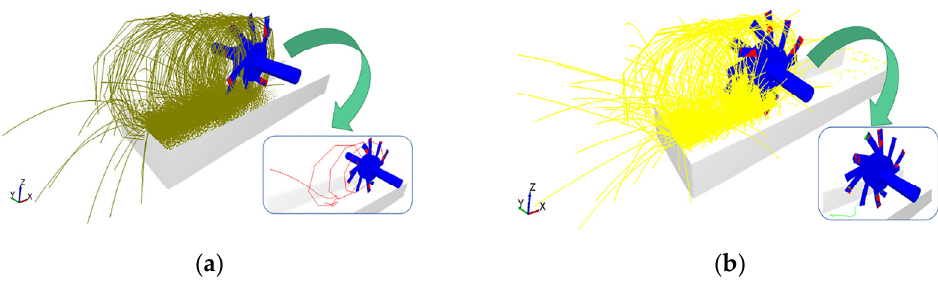
Figure 6. Simulation motion trajectory: ( a ) soil particles; ( b ) straw.